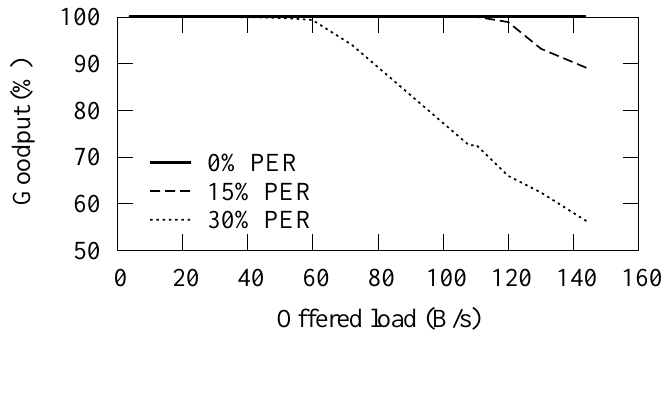
Figure 21. The effect of network load to the goodput in ZigBee using the reliable data forwarding.